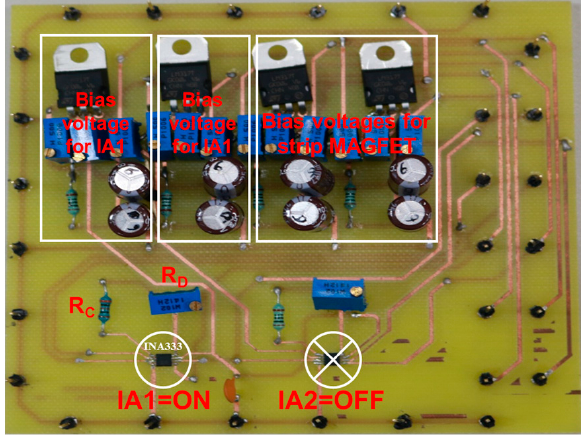
Figure 5. Applied PCB with two commercial instrumentation amplifiers (INA333).